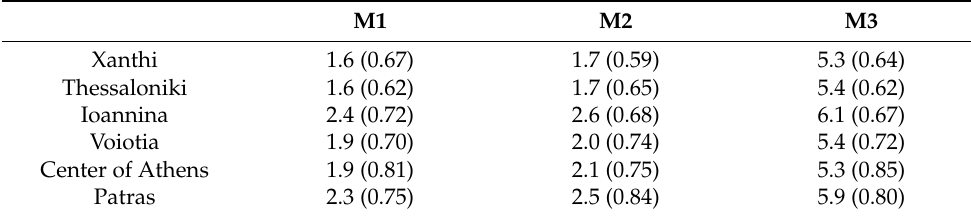
Table 10. Depth (mm) of natural carbonation and standard deviation at 36 months of